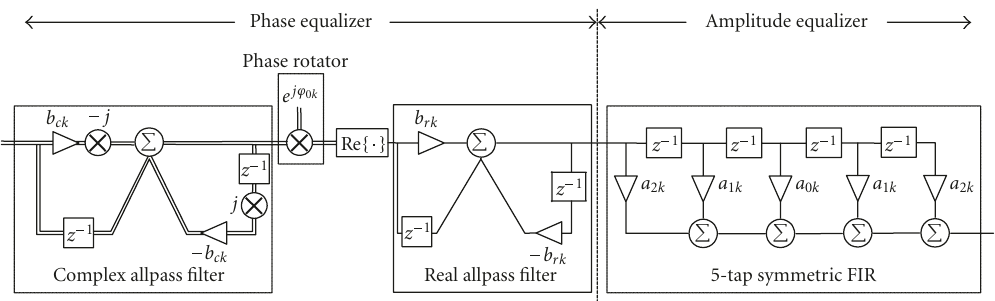
Figure 5: An example structure of the AP-SCE subcarrier